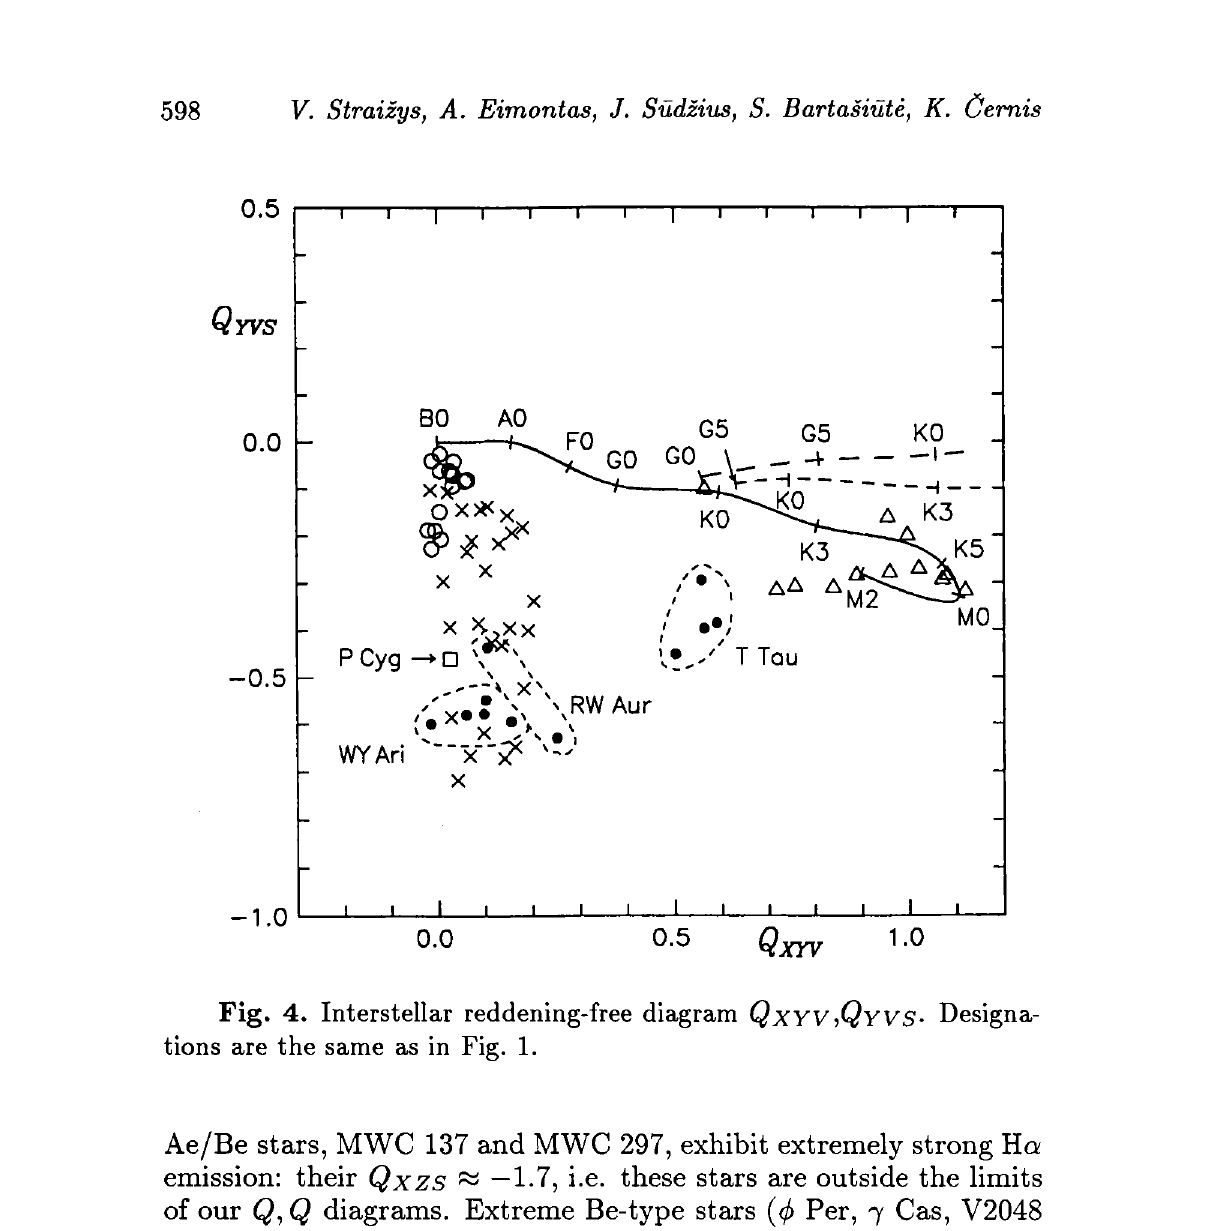
Fig. 4. Interstellar reddening-free diagram QXYV,QYVS- Designa- tions are the same as in Fig.